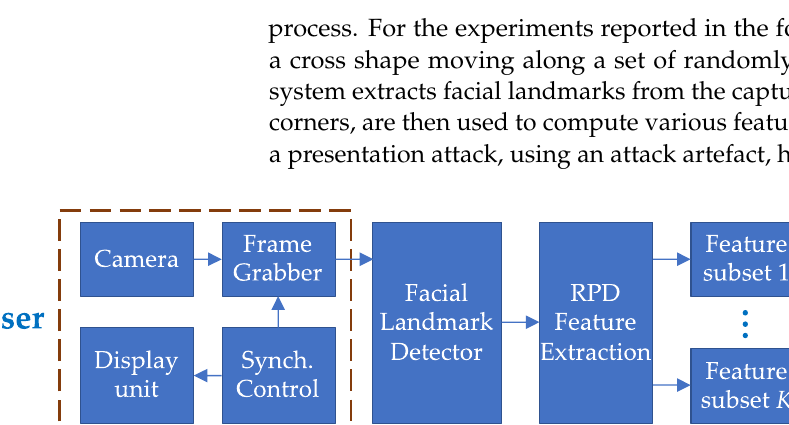
Figure 1. The block diagram of the proposed presentation attack detection (PAD) system. [RPD = Relative Pupillary Dis- placement].